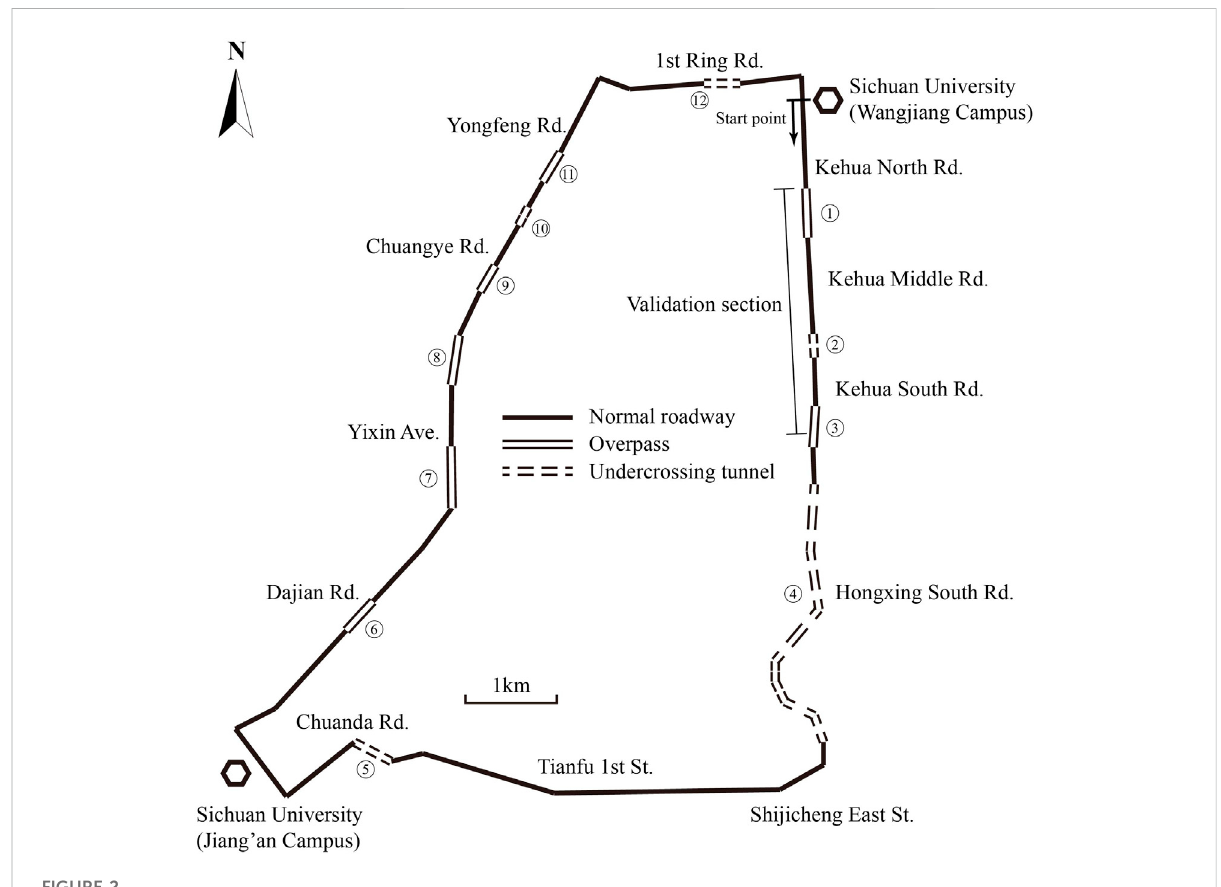
FIGURE 2 On-road measurement route and validation section.